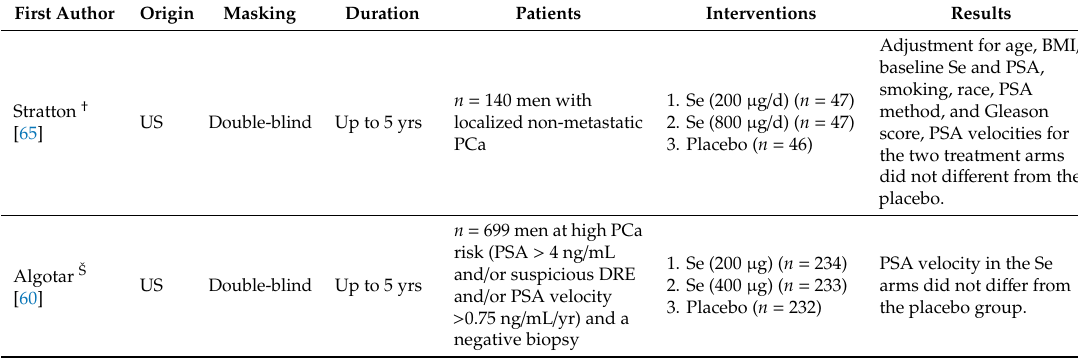
Table 2. RCTs examining the e ff ect of selenium ONS on the PSA concentrations among men with PCa or increased PCa